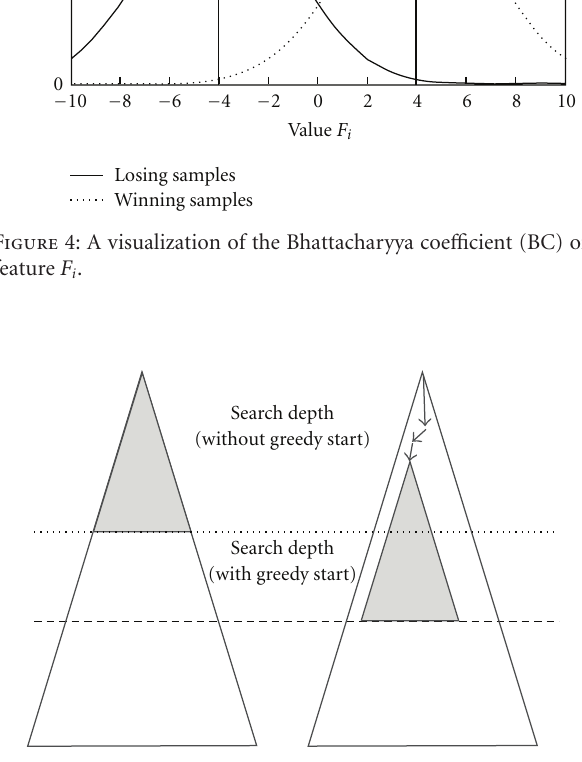
Figure 5: The increased space searchable with greedy search por-